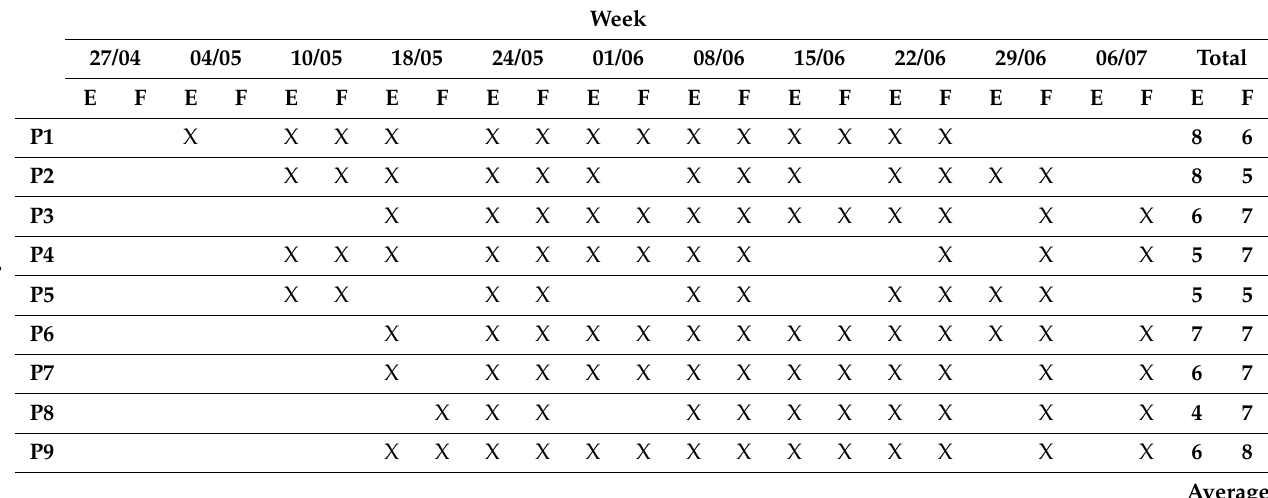
Table 3. Date of spray applications and total number of treatments performed for downy mildew control in EPI (E) and farmer (F) plots of the nine vineyards during 2021. Different letters indicate significant differences among samples ( p <